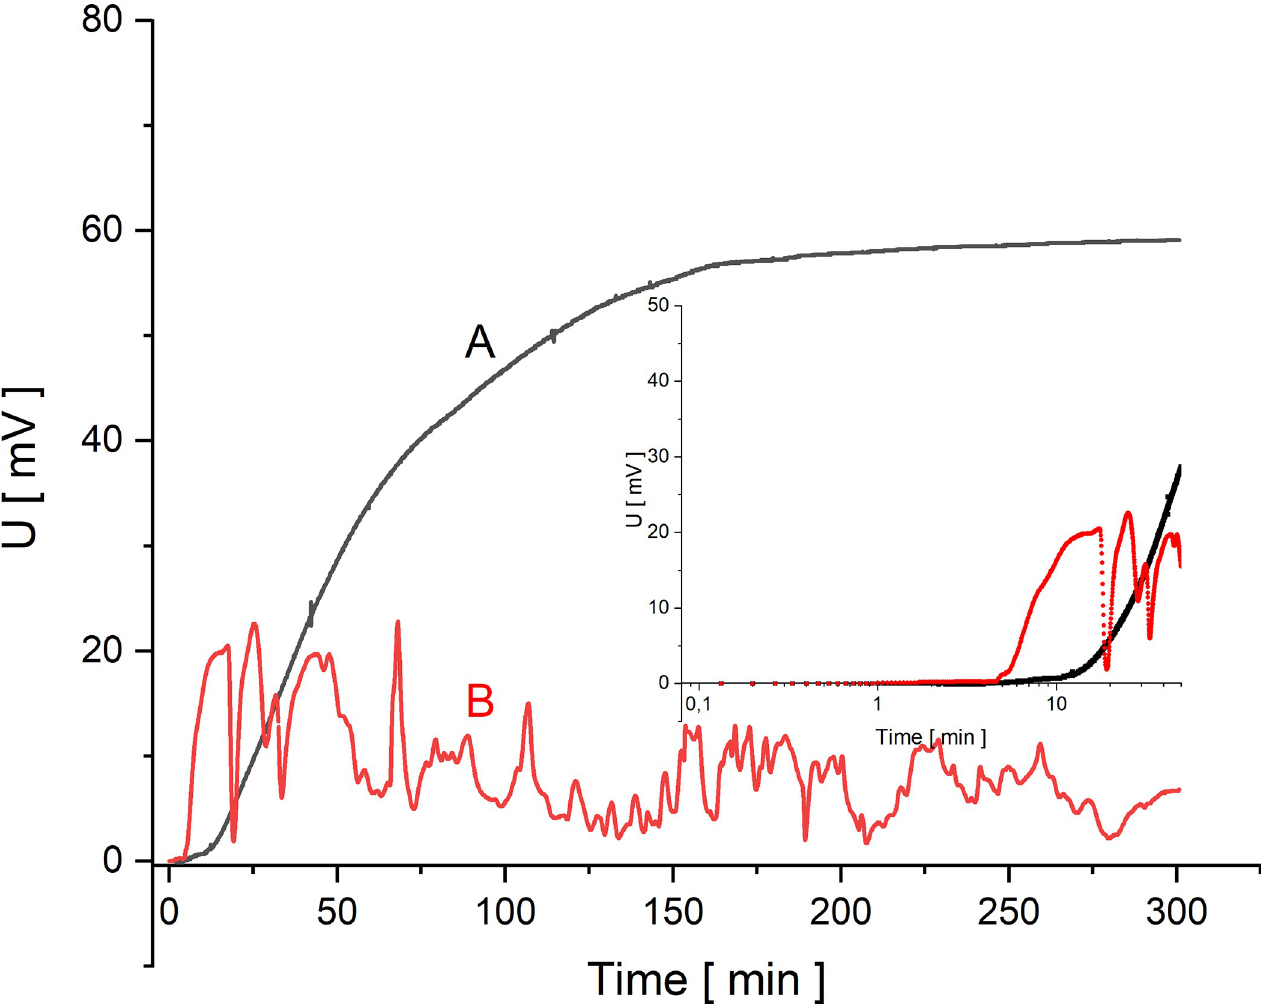
Fig 3. Voltage between electrodesin the chamberwith lower concentration as a functionof time for configurations A (black) and B (red) and for C h / C l = 500.